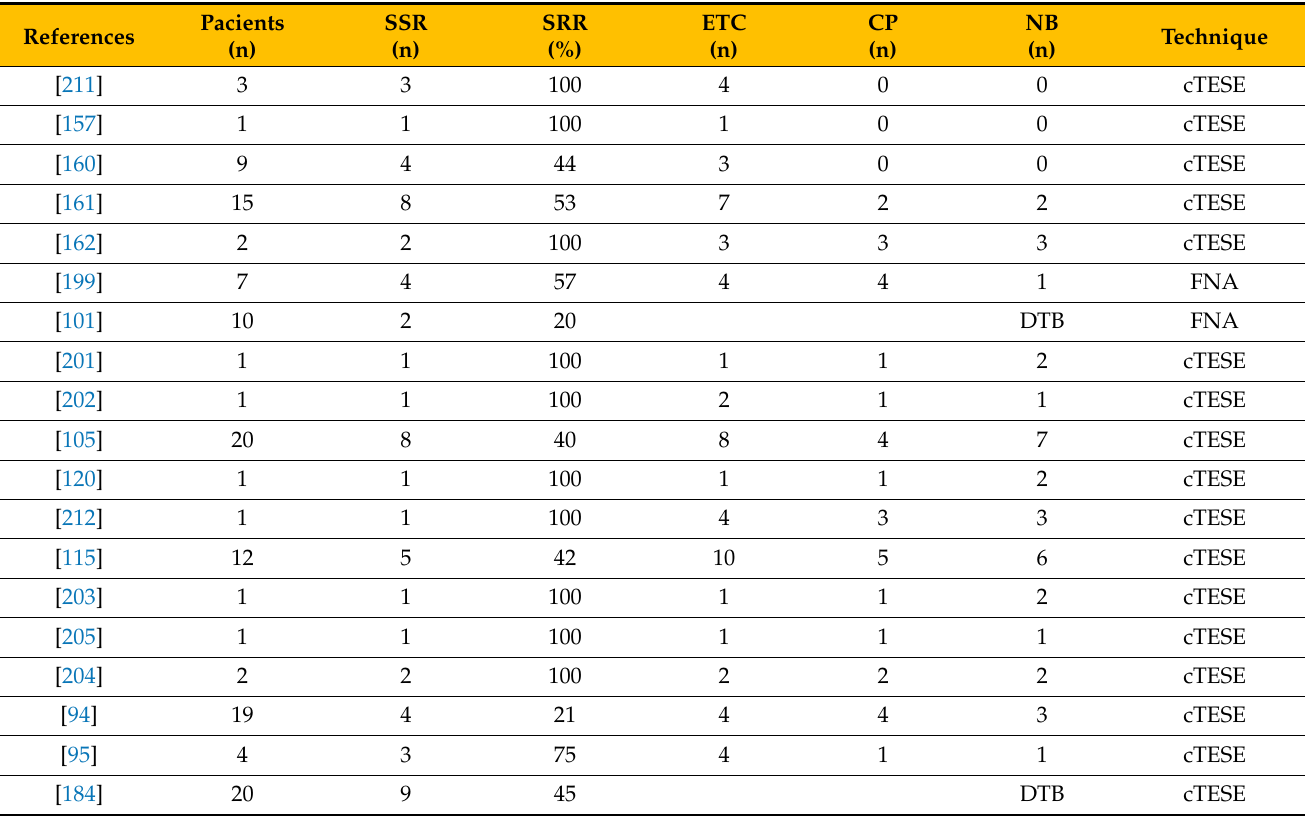
Table 1. Literature review on sperm retrieval and newborn outcomes in non-mosaic Klinefelter syndrome